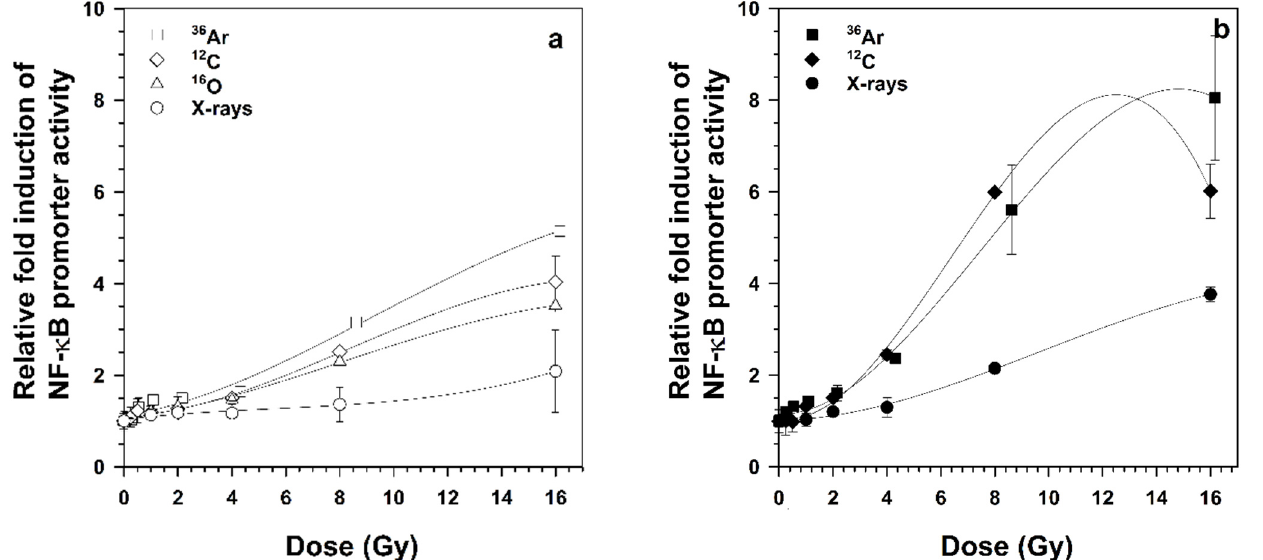
Figure 5. Relative fold induction of NF- κ B promoter activity. Cells were fixed 18 h after exposure to 36 Ar ions (LET 272 keV/ µ m), 12 C ions (LET 73 keV/ µ m), and 16 O ions (LET 51 keV/ µ m), and X-rays in the absence ( a ) or presence ( b ) of Shield-1. The fluorescence of NF κ B-DD-tdTomato cells was analyzed using flow cytometry. The relative fold induction of NF- κ B promoter activity was calculated by dividing the geometrical mean of fluorescence intensity (MFI) of the irradiated cells by the MFI of the non-irradiated control. Mean ± SD ( n = 2) are shown.